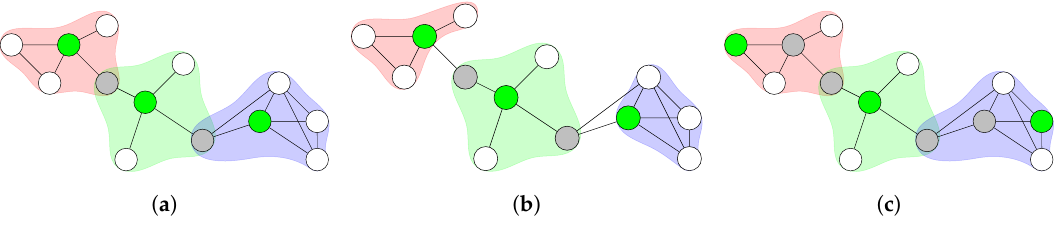
Figure 6. Network clustering. Colored areas around nodes represent clusters. Cluster heads are colored in green. Gateways or distributed gateways are colored in grey. ( a ) Clustering with overlapping clusters. ( b ) Clustering with non-overlapping clusters. ( c ) Clustering with distributed